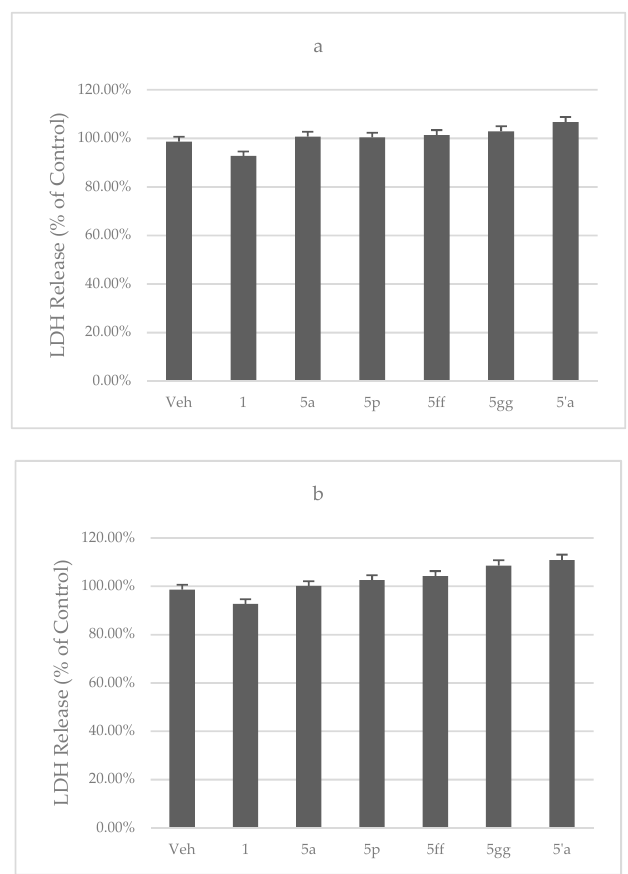
Figure 6. Toxicity on platelets of some of ginkgolide-1,2,3-triazole derivatives: ( a ) Tested at 1 µ M concentration. ( b ) Tested at 10 µ M concentration. Ginkgolide B ( 1 ) was used as reference.